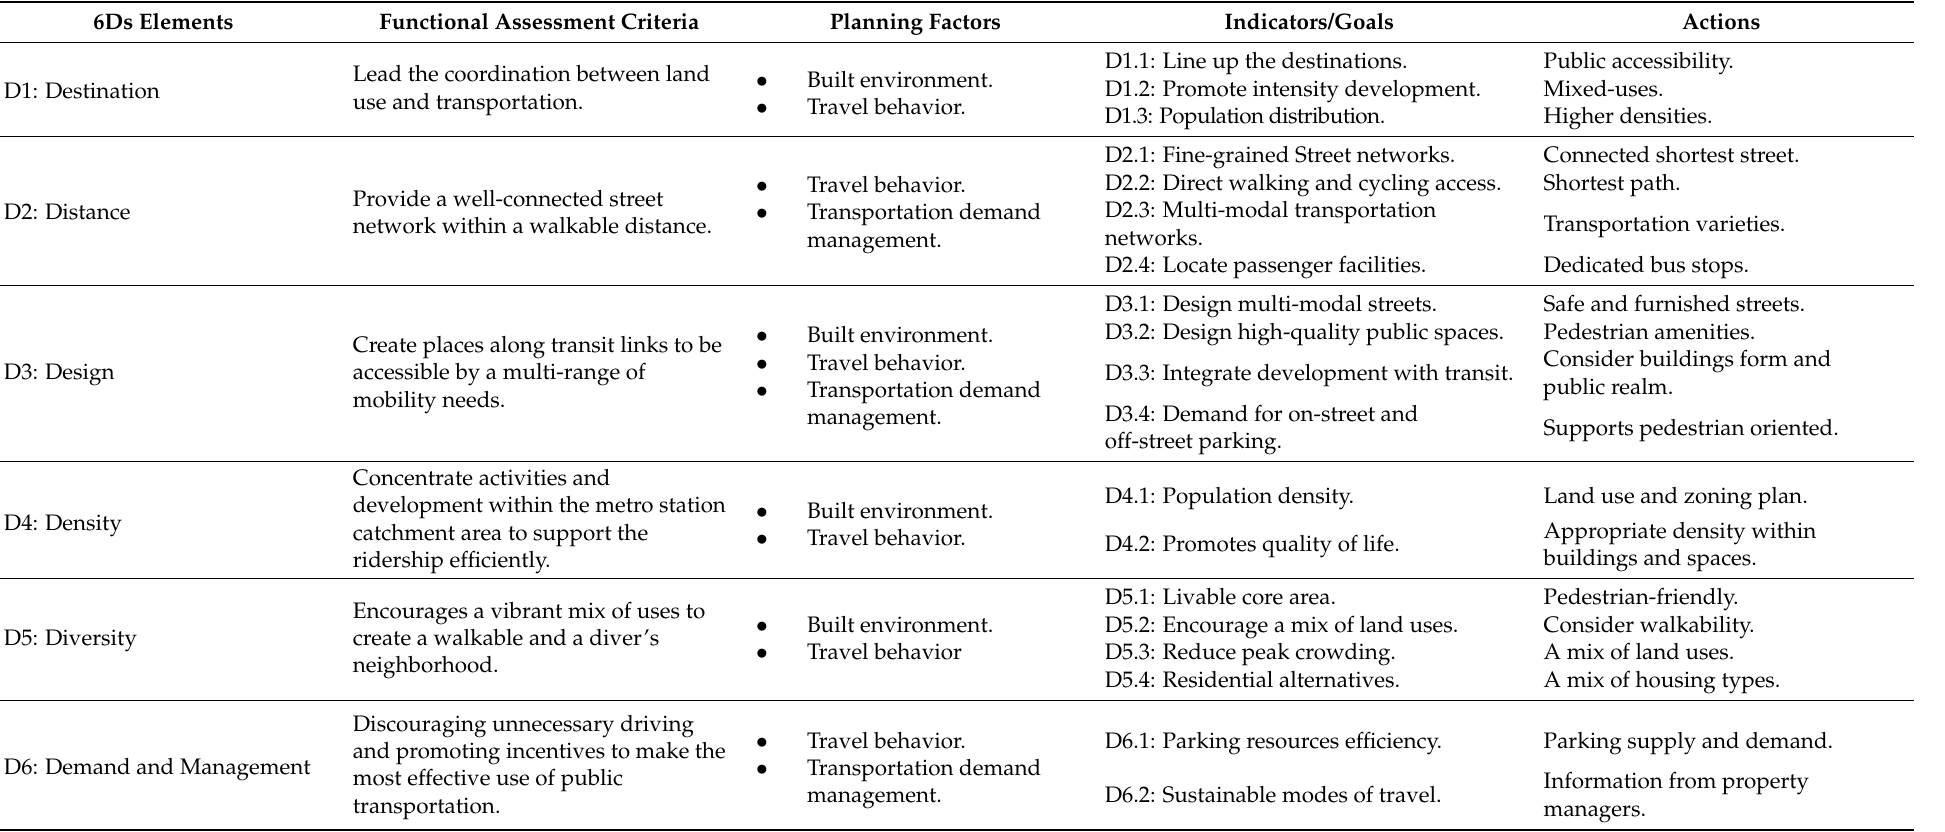
Table 1. 6Ds TOD assessment model versus functional assessment criteria and planning factors (source: Data modified from